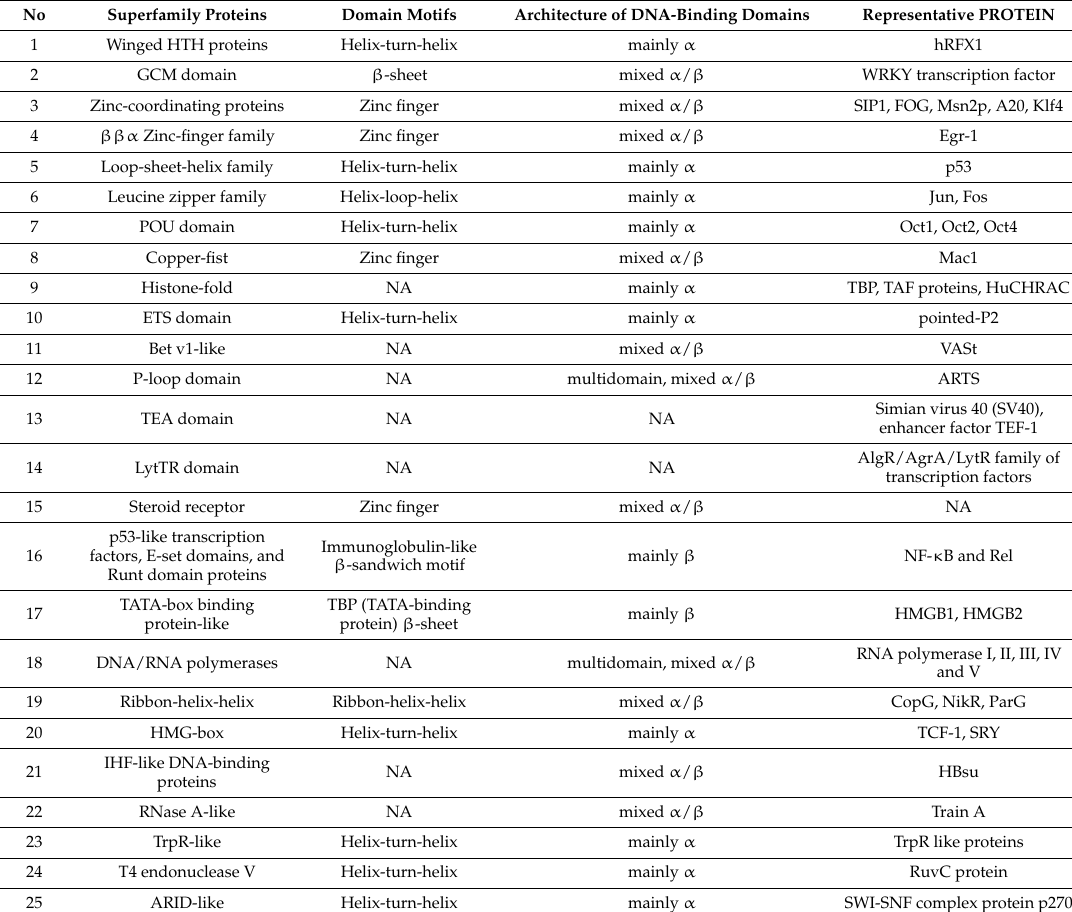
Table 1. Different domain family proteins and their domain